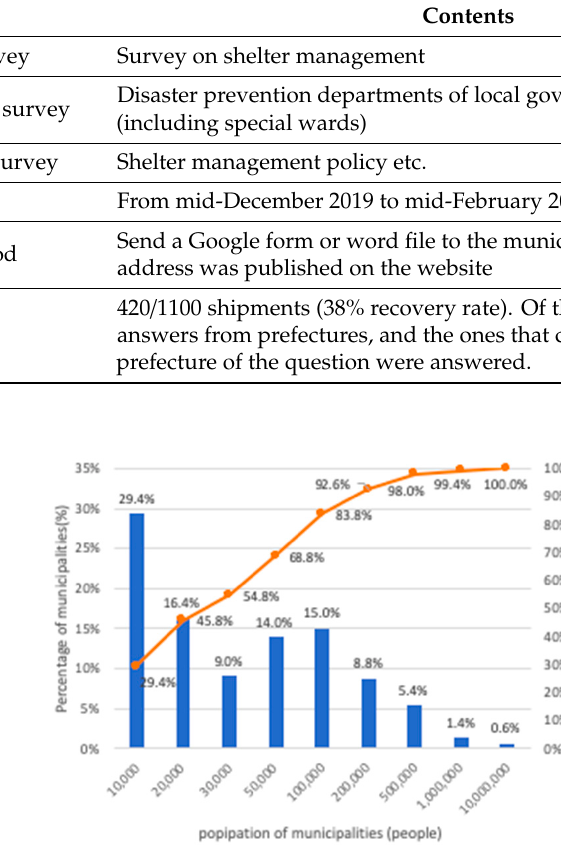
Figure 1. Population scale by municipality nationwide.